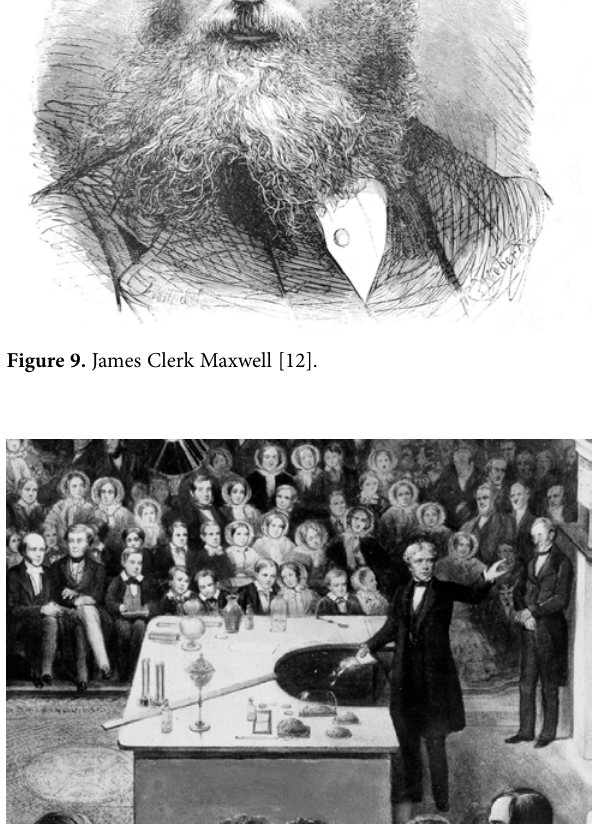
Figure 10. M. Faraday while holding a lecture at the Royal Institu- tion in London [13].